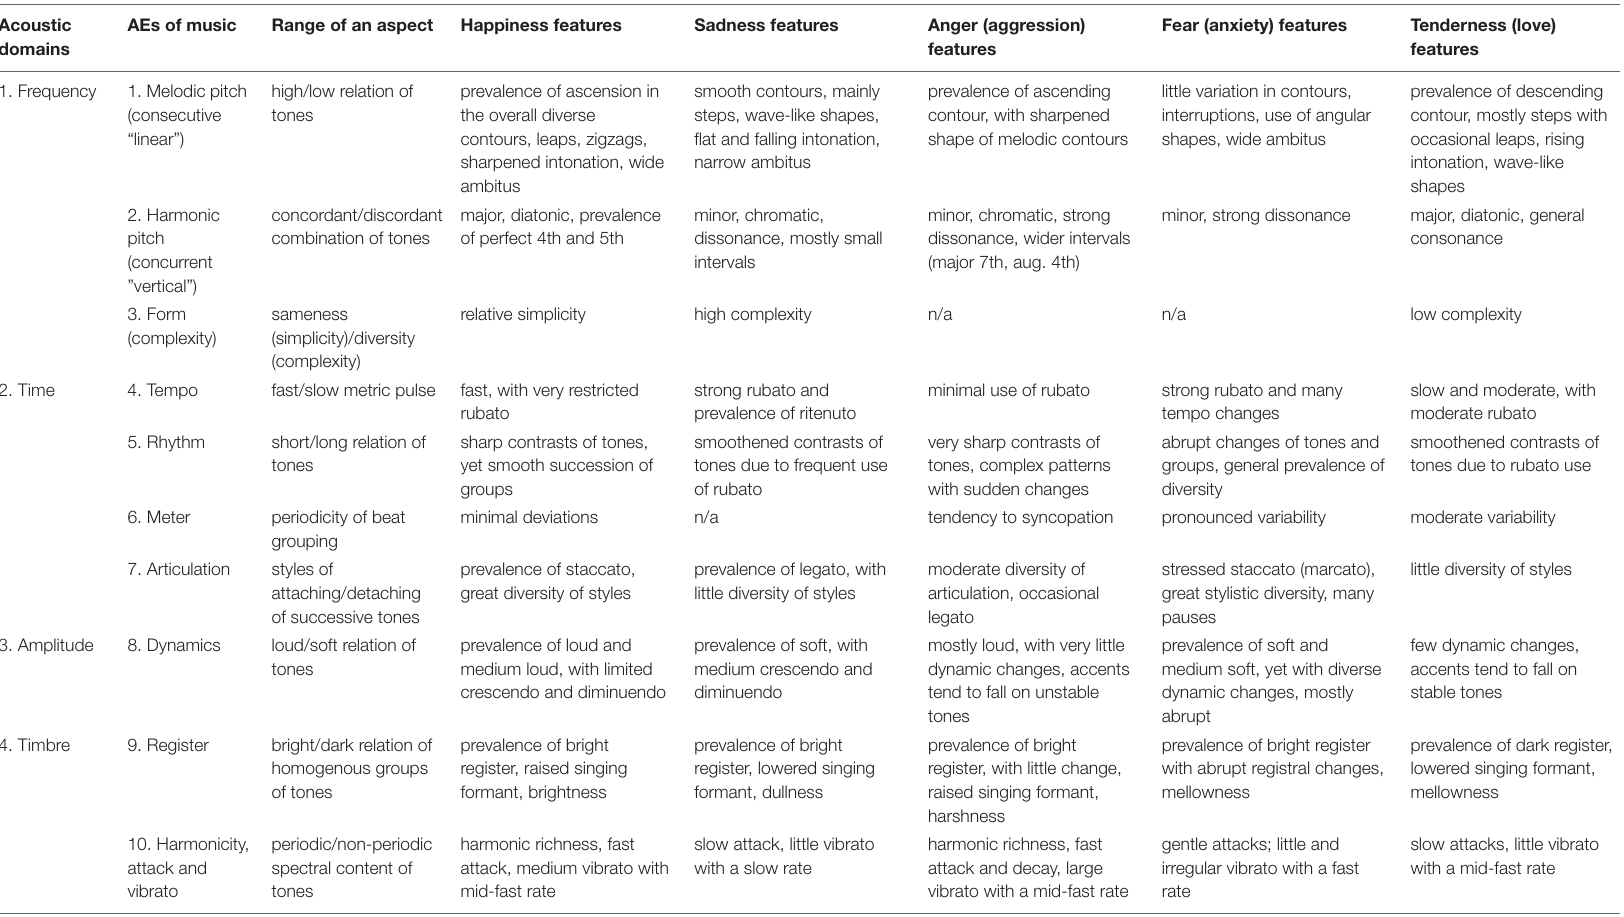
TABLE 5 | The acoustic attributes of typical expression of 5 basic emotions in human music that find no correspondences in animal communication (based on Tables 3 , 4